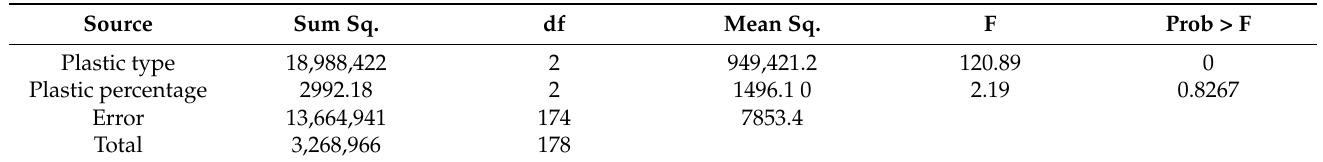
Table 7. The results of using ANOVA to verify the statistical significance of the impact of plastic type and plastic percentage on the on the feed force (F (N)).